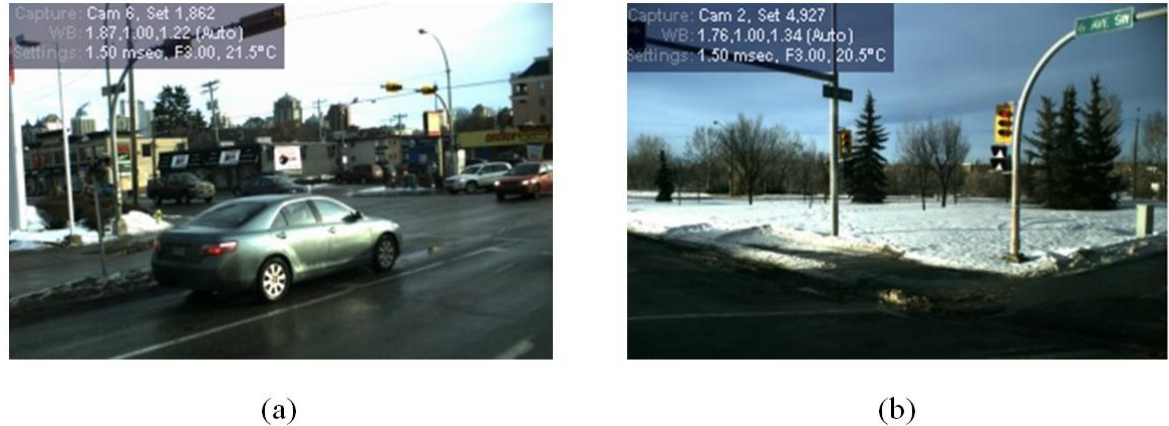
Figure 11. Two scenes contain some lamp poles at the City of Calgary, Canada ( a ) for Dataset 3 ( b ) for Dataset 4